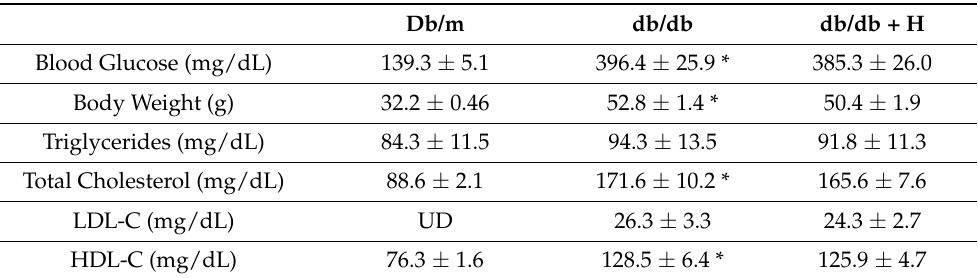
Table 1. Metabolic and biochemical parameters in non-diabetic (db/m), untreated diabetic (db/db) and hidrosmin-treated diabetic (db/db + H) mice. Data are expressed as mean ± SEM of n = 10 animals per group. * p < 0.05 vs. db/m analyzed separately by Mann–Whitney U test. Abbreviations: HDL-C, HDL cholesterol; LDL-C, LDL cholesterol; ASAT, aspartate aminotransferase; ALAT, alanine aminotransferase; BUN, blood urea nitrogen; UD,